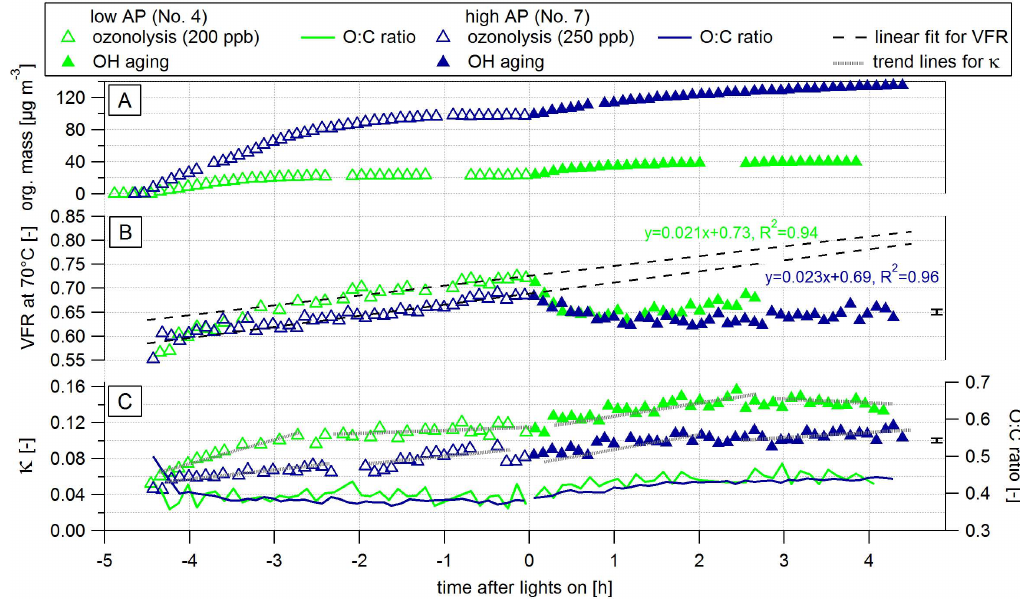
Fig. 6. Time series of two α -pinene (AP) ozonolysis experiments followed by reaction with OH from HONO photolysis. The two periods of the experiment, ozonolysis and reaction with OH, are distinguished by open and closed symbols, respectively, and green and blue color is used for the low (10ppb) and high (40ppb) AP precursor concentration experiment, respectively. Panel (a) shows the organic aerosol mass (wall-loss corrected), panel (b) the VFR at 70 ◦ C and in panel (c) the hygroscopicity parameter κ (left axis) as well as the O:C ratio (right axis). The evolution of the VFR during ripening (ca. from − 3 to 0h) was linearly fitted and extrapolated to indicate the trend expected without reaction with OH. The grey dotted lines shown in panel (c) help to guide the eye to see the changing trends of κ in the four periods of the experiment. Exemplary error bars in panel (b) and (c) represent the reproducibility for volatility and hygroscopicity data, respectively. Additional scatter of the data points is caused by the fact that different dry sizes are